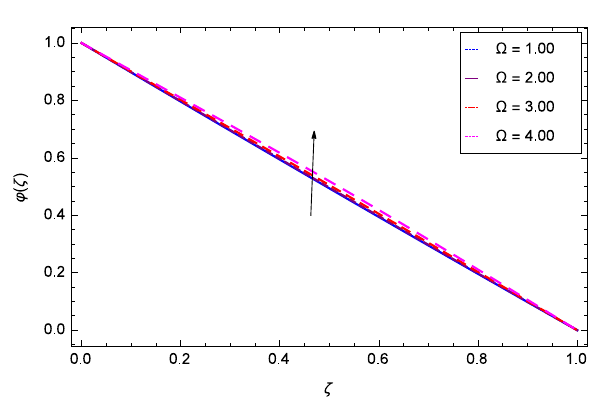
Figure 22. Analysis through rotation parameter (cid:31) and nanoparticles concentration ϕ ( ζ ).